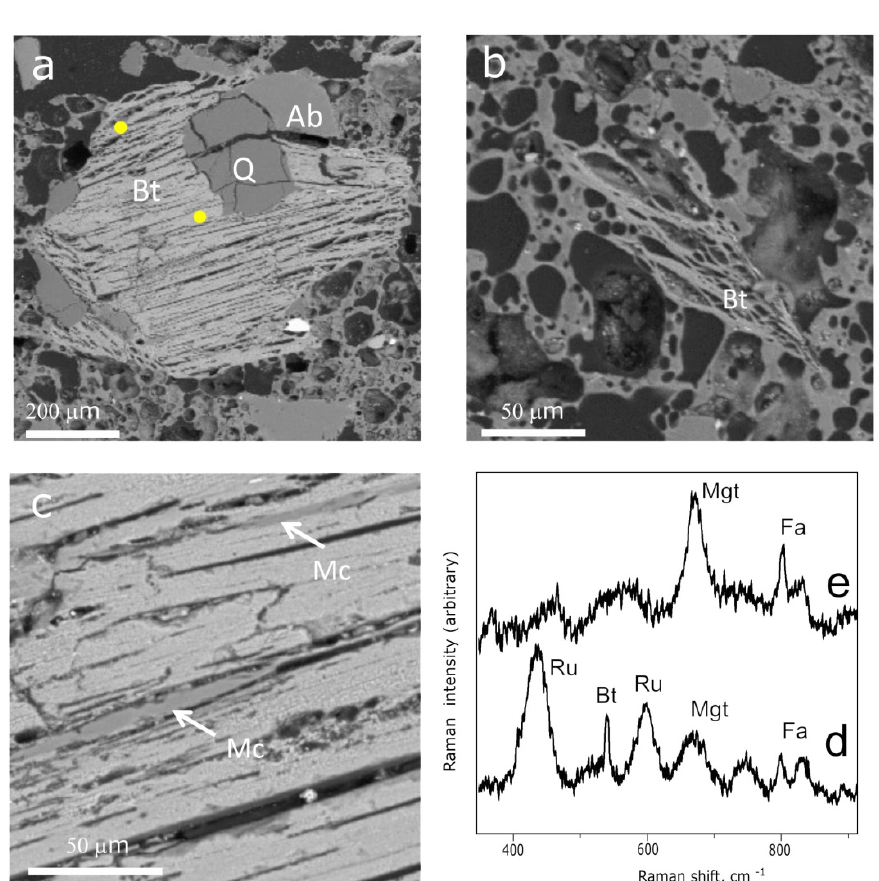
Figure 6. BSE image of biotite from the central zone ( a ) and the outer edge; ( b ) of the crucible; SEM image of microcline lamella between the cleavage planes of biotite shown in ( a ); ( c ); Raman spectra obtained from the central zone; ( d ) and margin; ( e ) of biotite shown in ( a ). The yellow dots mark the point Raman analysis. Abbreviations: Ab—albite; Bt—biotite; Fa—fayalite; Mc—microcline; Mgt—magnetite; Q—quartz; Ru—rutile.